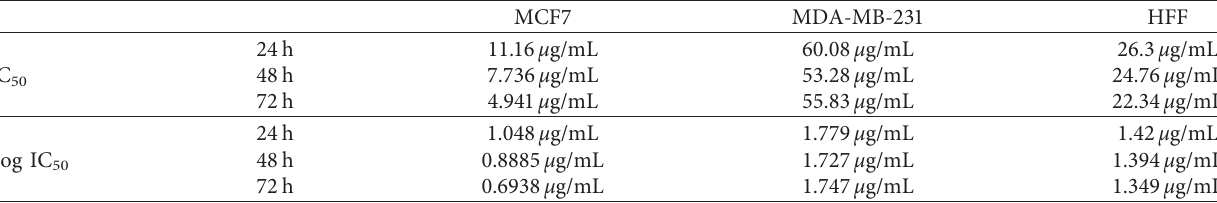
Figure 2: MTTassay analysis. Results were presented as mean ± SD ( n � 3). The IC 50 value was calculated as 11.16 μ g/mL, 26.3 μ g/mL, and 60.08 μ g/mL for MCF7, HFF, and MDA-MB-231, respectively, after 24h incubation with ZnO-NPs. The diagrams were performed by Tukey comparison and showed the antiproliferative capacity of ZnO-NPs against HFF (a), MCF7 (b), and MDA-MB-231 (c) cell lines after 24, 48, and 72 hours, respectively. The nonlinear regression sigmoidal dose-response and logarithmic transformation of ZnO concentration showed the logarithmic concentrations tested on cell lines after 24, 48, and 72 hours (d–f). Two-way ANOVA showed a significant level between different times and concentrations of MCF7, HFF, and MDA-MB-231 cell lines (g–i). Table 2: The nonlinear regression sigmoidal dose-response curve calculated the different IC 50 values of ZnO-NPs for the breast cancer cell lines (MCF7 and MDA-MB-231) and